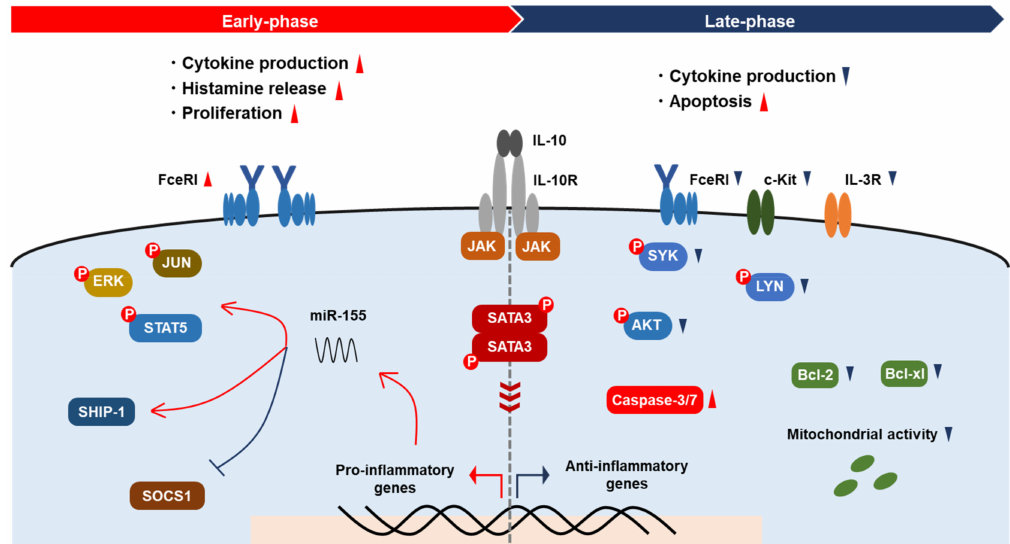
Figure 1. Modulation of MC activation by IL-10. IL-10 promotes cytokine production, histamine release, and the proliferation of MCs via augmentation of Fc ε RI signaling and miR-155 expression in the early phase, resulting in the activation of kinases and transcription factors and the suppression of SOCS1. In the late phase, IL-10 reduces cytokine production and induces apoptosis. The expression of IL-3R and c-Kit on MCs decreases via IL-10. IL-10 downregulates signaling molecules, including Syk, Lyn, and Akt, and apoptosis inhibitors Bcl-xl and Bcl-2, resulting in mitochondrial